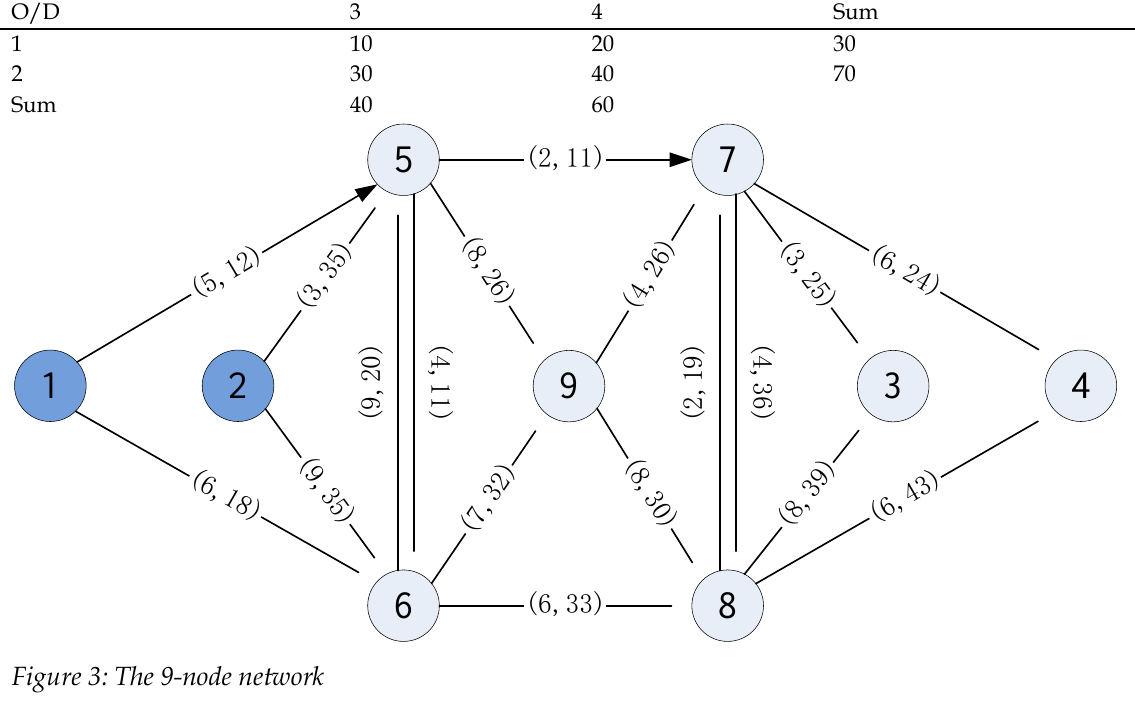
Figure 3: The 9-node network Figure 4 shows the NTE link